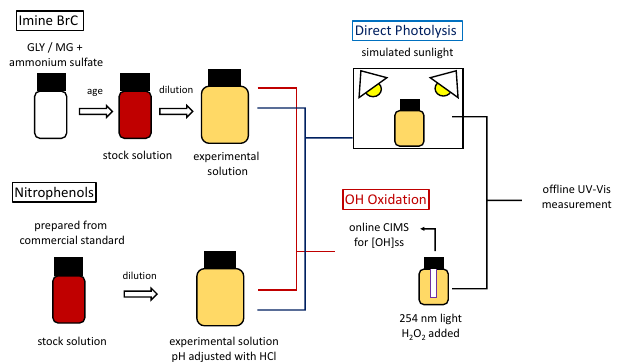
Figure 1. Experimental procedures.